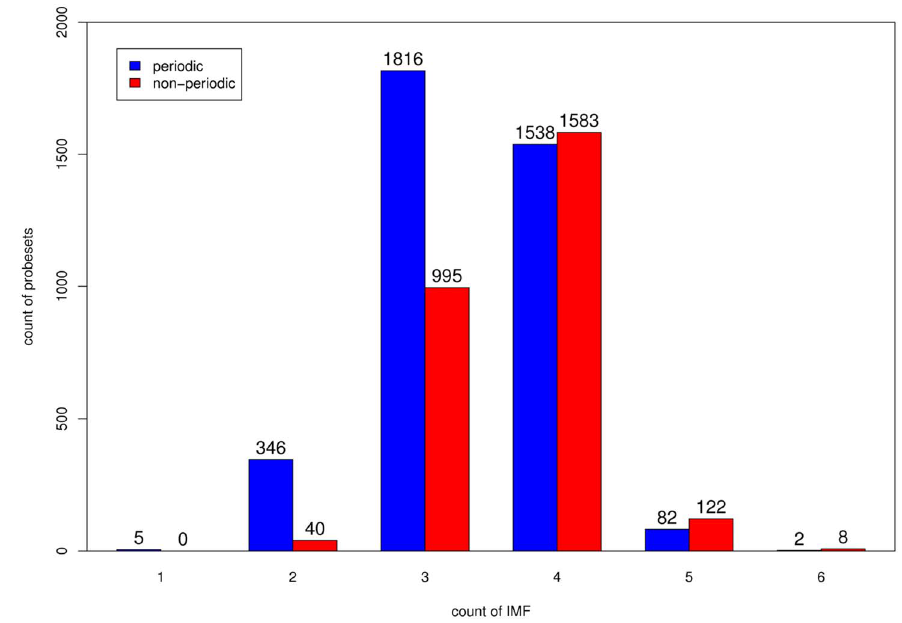
Figure 3. Impact of the IMF. Distribution of the number of extracted IMFs for 6537 YMC probesets.